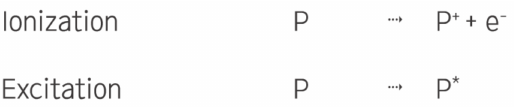
Figure 1. Major reactions in polymer materials by gamma irradiation.